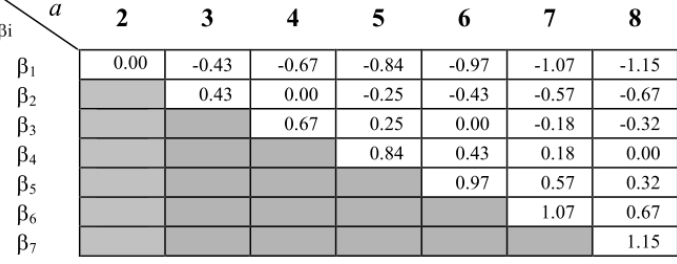
Figure 3. Statistical table used in the definition of breakpoints [33].